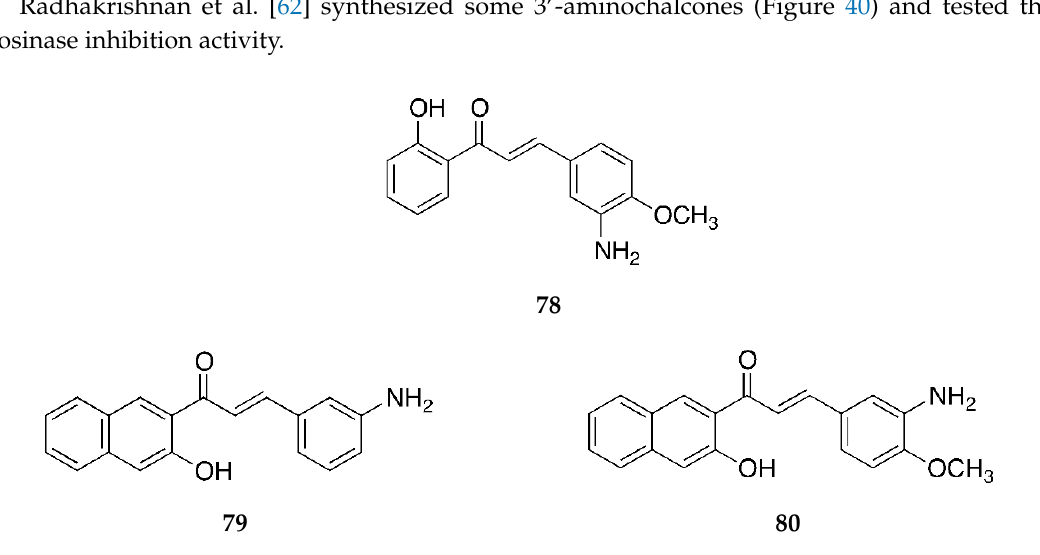
Figure40. Chemicalstructuresof3 (cid:48) -aminochalconederivativeswithhydroxyandmethoxysubstitutions Figure 40. Chemical structures of 3′-aminochalcone derivatives with hydroxy and methoxy on ring A and ring substitutions on ring A and ring B.